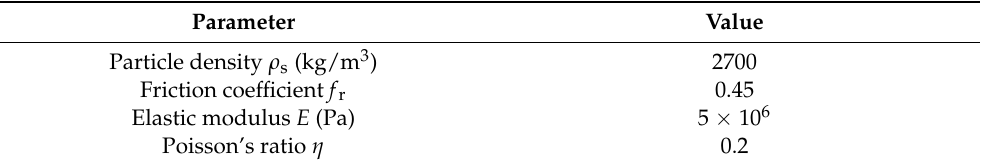
Table 1. Parameters for the sand particles in the simulation.